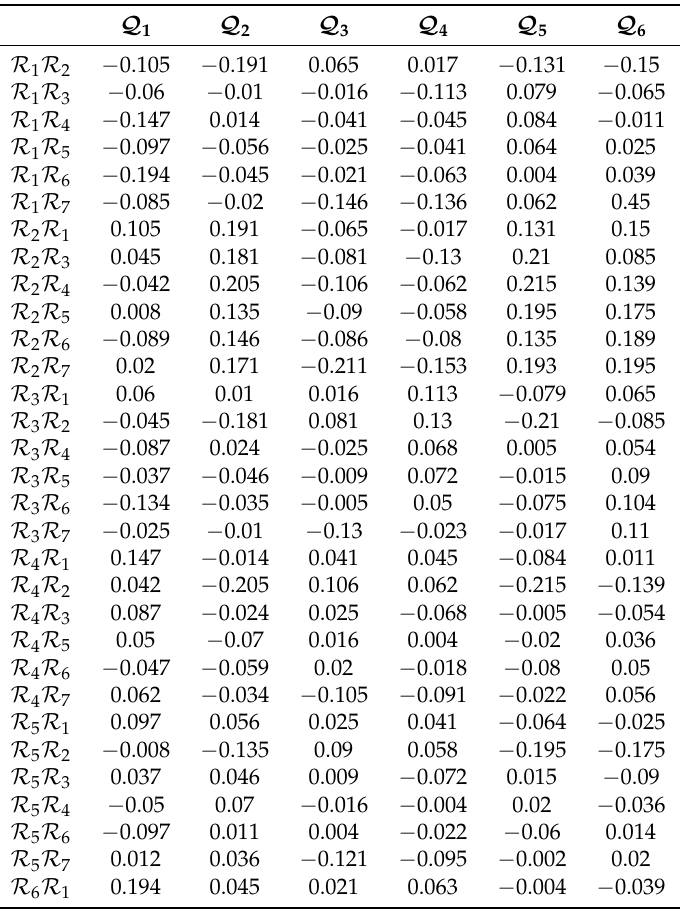
Table 8. Deviation of alternatives with respect to